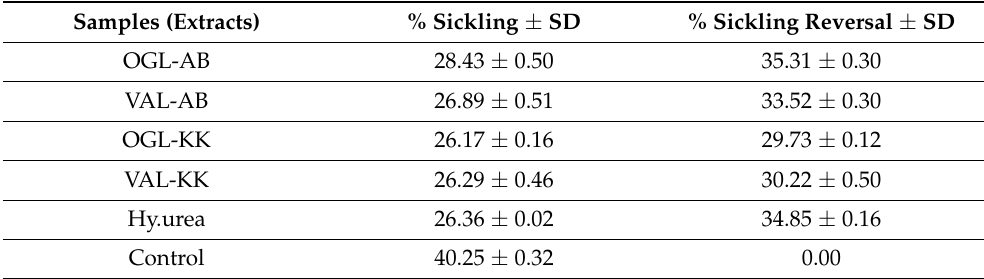
Table 3. Percentage of sickling of erythrocytes treated without extracts (negative control), hydrox- yurea (positive control) and with 10 mg/mL